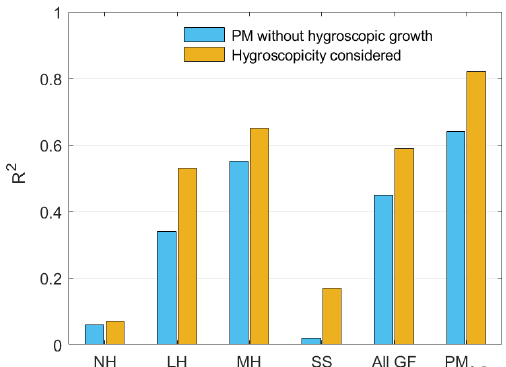
Figure 11. The R squares between visibility and PM volume con- centrations with and without considering particle